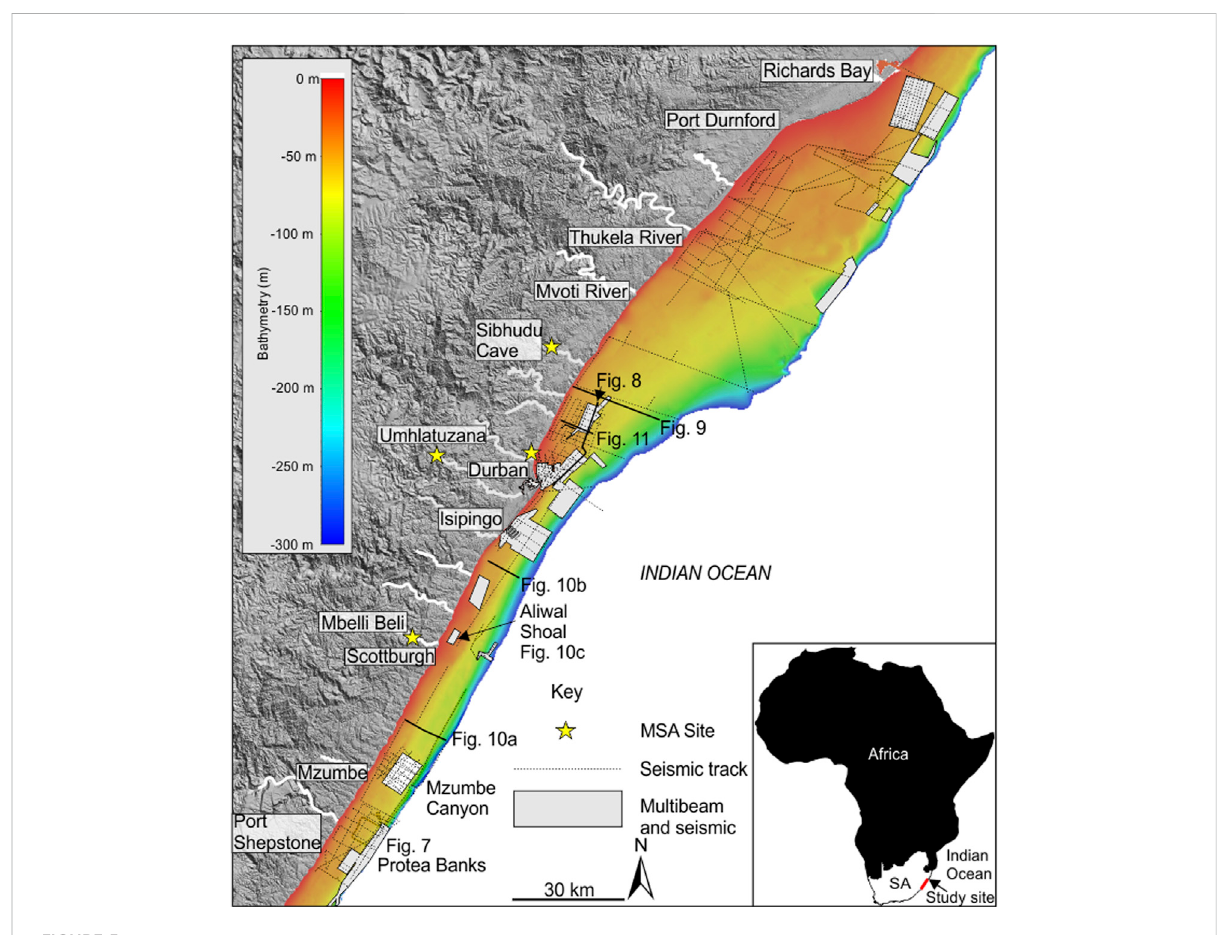
FIGURE 5 Geophysical data coverage of the KwaZulu-Natal shelf, superimposed on the general shelf bathymetry (after de Wet and Compton, 2021). Key data localities discussed in the paper are highlighted in bold.